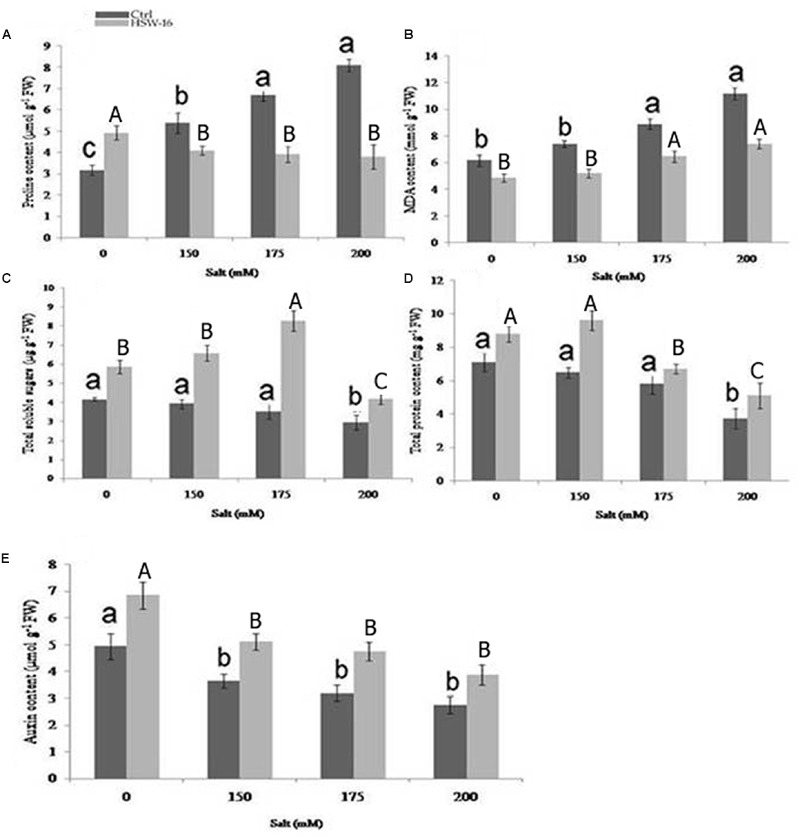
Effect of B. licheniformis HSW-16 inoculation on (A) proline (B) malondialdehyde (MDA) (C) total soluble sugar (TSS) (D) total protein, and (E) auxin content under different 0 mM, 150 mM, 175 mM, 200 mM NaCl salinity conditions. Values are mean of five replicates ± SD. Small letters on the bar in each treatment indicate significant difference (p < 0.05) among control, whereas capital letters indicate significant difference among the bacterial treatment. Dark and light gray columns represent the control and HSW-16 inoculated plants, respectively.